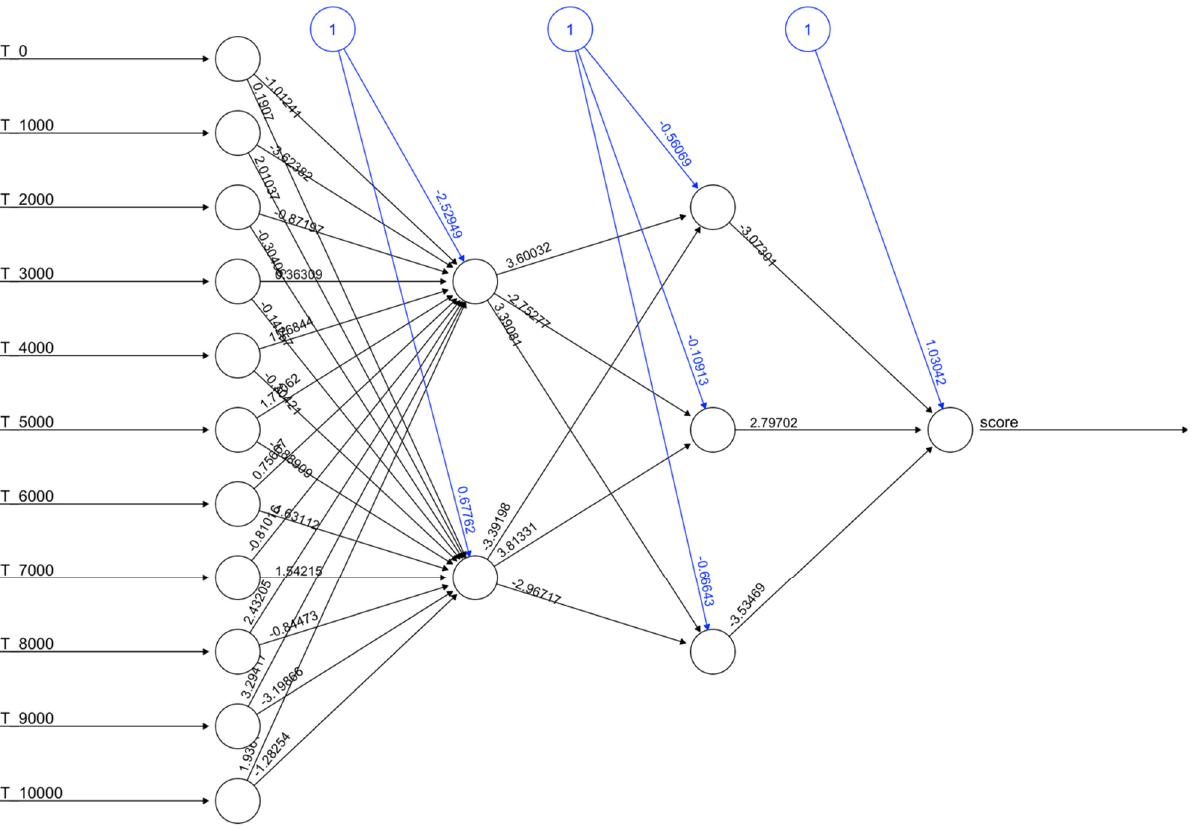
Figure 2. Graphical representation of the neural network. Graphical representation of the model with the weights on each connection. The black lines show the connections between each layer and the weights on each connection while the blue lines show the bias term added at each step.